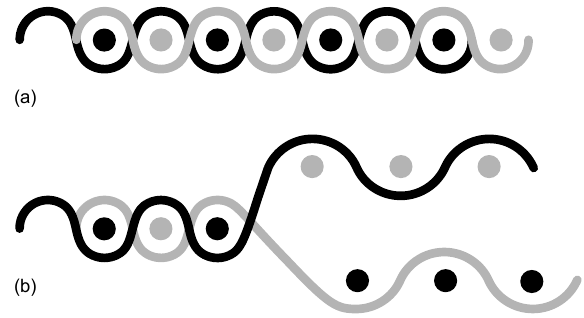
Figure 3. Plain weave ( a ) and the seam of a one-piece-woven airbag ( b